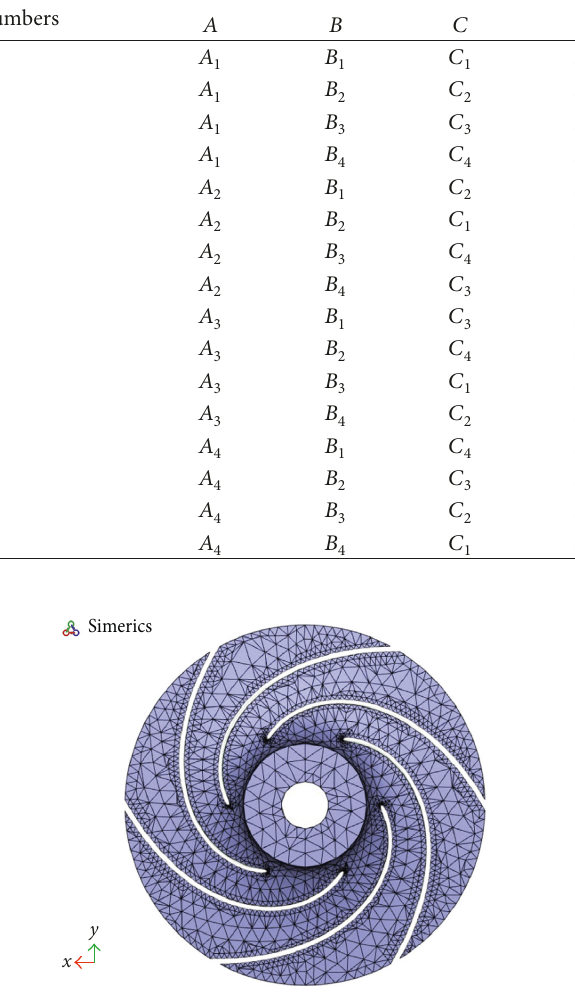
Figure 2: Impeller grid division.